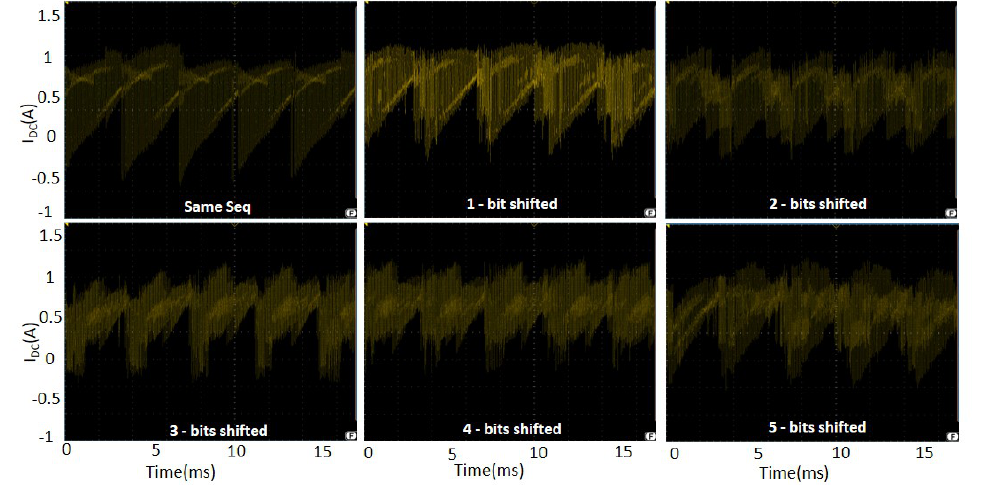
Figure 17. Experimental DC − link current for sequence-shifted interleaving at 60 ◦ pf angle.